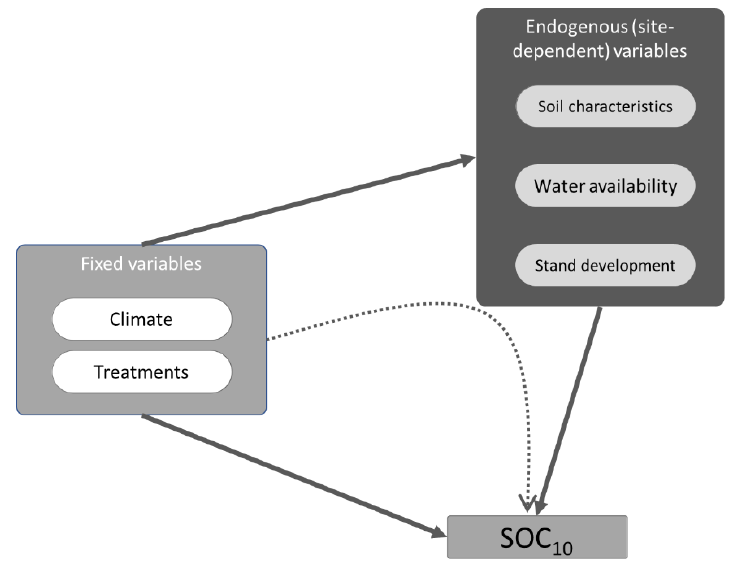
Figure 2. Conceptual model for relationships between environmental variables, site variables and carbon content. Regular arrows show direct effects, and dashed line indicates indirect effects.